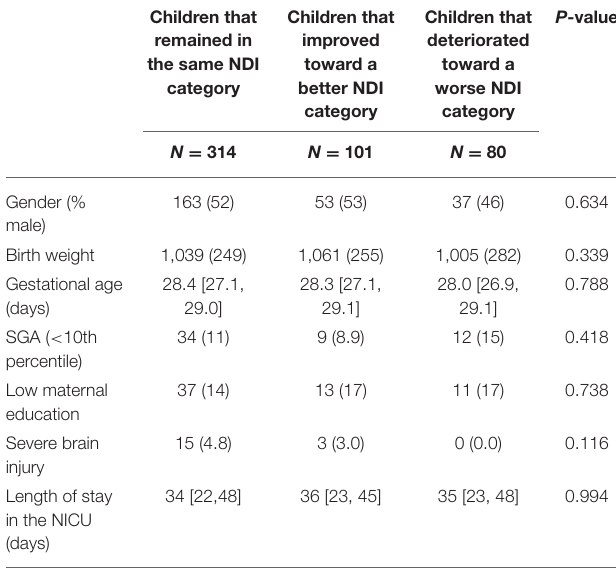
TABLE 5 | Baseline characteristics of children that remained in the same NDI category, improved toward a better NDI category and deteriorated toward a worse NDI